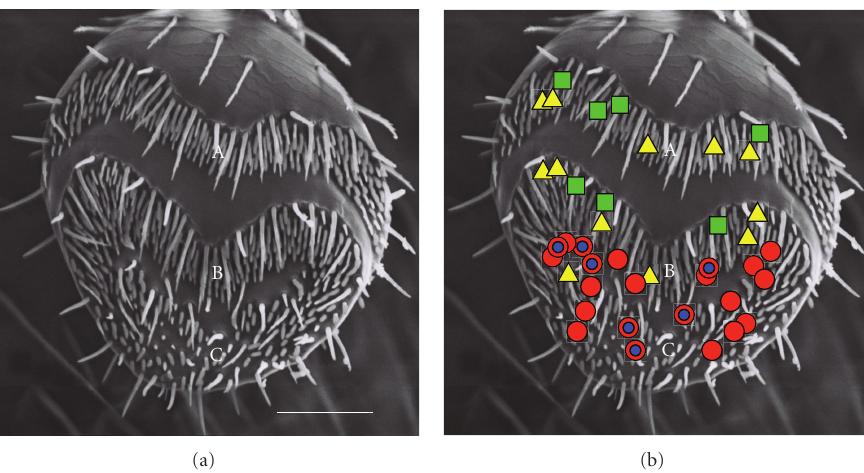
Figure 2: (a) Olfactory sensilla are present in three areas (A, B, and C) on the antennal club of Ips typographus . (b) Spatial distribution patterns of four classes of olfactory receptor neurons (ORNs). ORNs responding to green leaf volatile alcohols (nonhost) = green squares, myrcene (host) = yellow triangles, cis -verbenol (pheromone) = red circles, 1,8-cineole (host) = blue small circles (from [19], with permission from the publisher). Scale bar = 50 μ m.